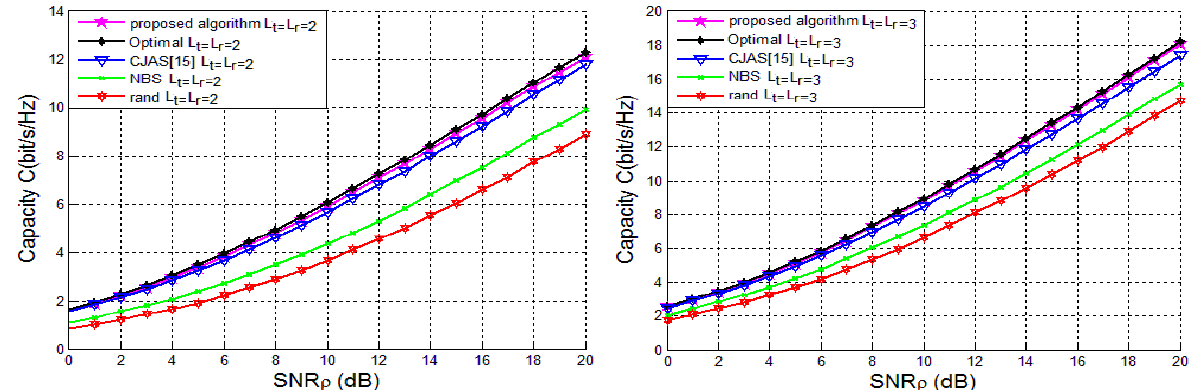
Fig. 6 statistical capacity versus SNR for { 7 , 2;7 , 2 } system